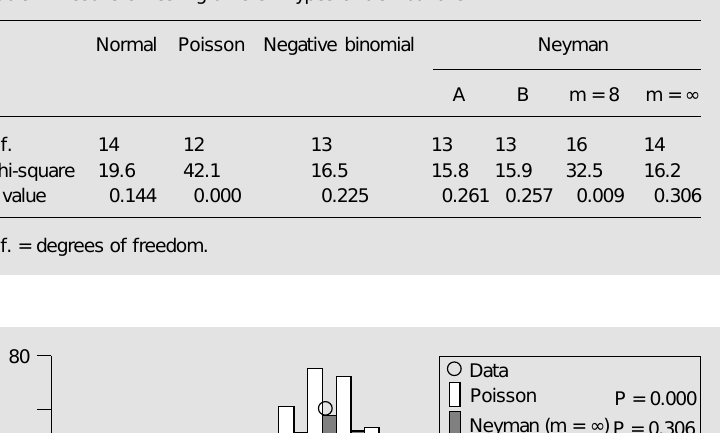
Table 1. Results of testing different types of distributions.